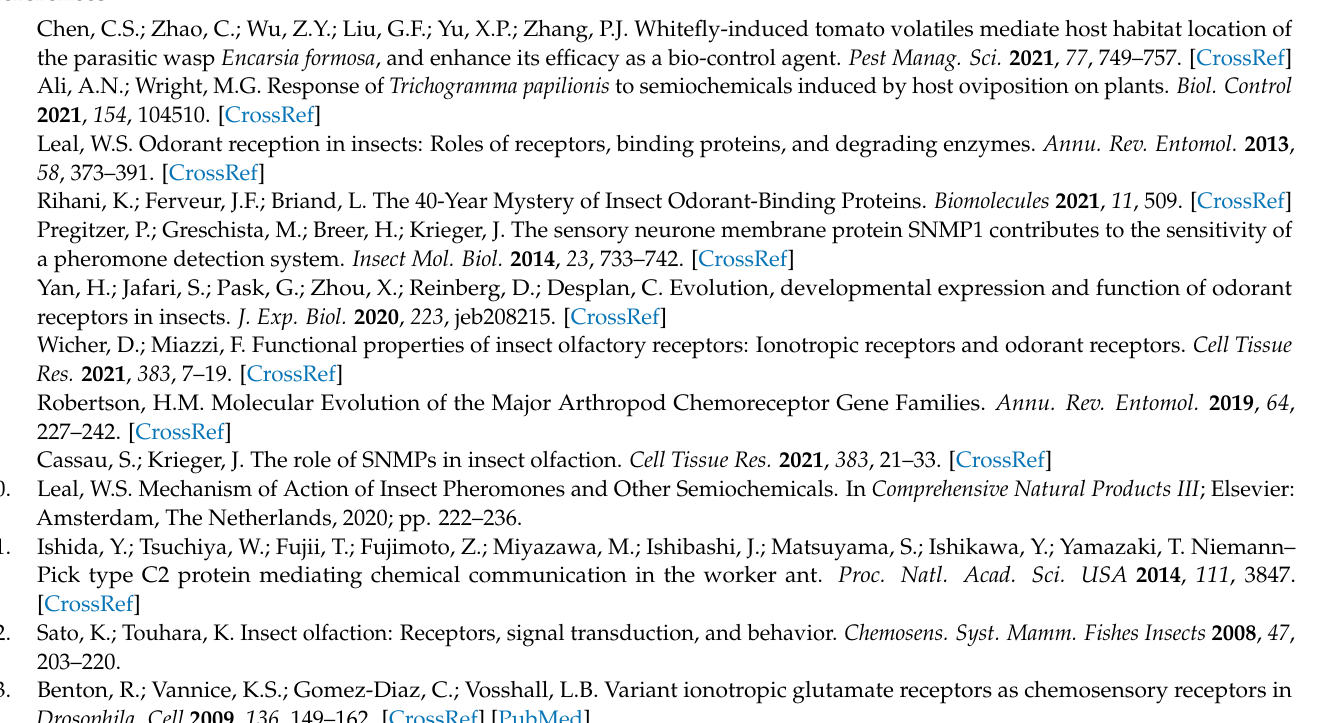
Table S8. Sequence information of identified GRs in B. dioryctriae ; Table S9. Sequence information of identified SNMPs in B. dioryctriae ; Table S10. The FPKM values of chemosensory genes in B. dioryctriae; Table S11. Primers of candidate chemosensory genes and GAPDH used for RT-qPCR. Supplementary Data S1. The amino acid sequences of 233 odorant-binding proteins (OBPs) from eight Hymenoptera species; Supplementary Data S2. The amino acid sequences of 91 chemosensory proteins (CSPs) from 12 Hymenoptera species; Supplementary Data S3. The amino acid sequences of 29 Niemann– Pick type C2 proteins (NPC2s) from 11 Hymenoptera species; Supplementary Data S4. The amino acid sequences of 705 odorant receptors (ORs) from four Hymenoptera species; Supplementary Data S5. The amino acid sequences of 211 ionotropic receptors (IRs) from 15 Hymenoptera species; Supplementary Data S6. The amino acid sequences of 120 gustatory receptors (GRs) from ten insect species; Supplementary Data S7. The amino acid sequences of 29 SNMPs from 13 Hymenoptera species and ten CD36 proteins from five insect